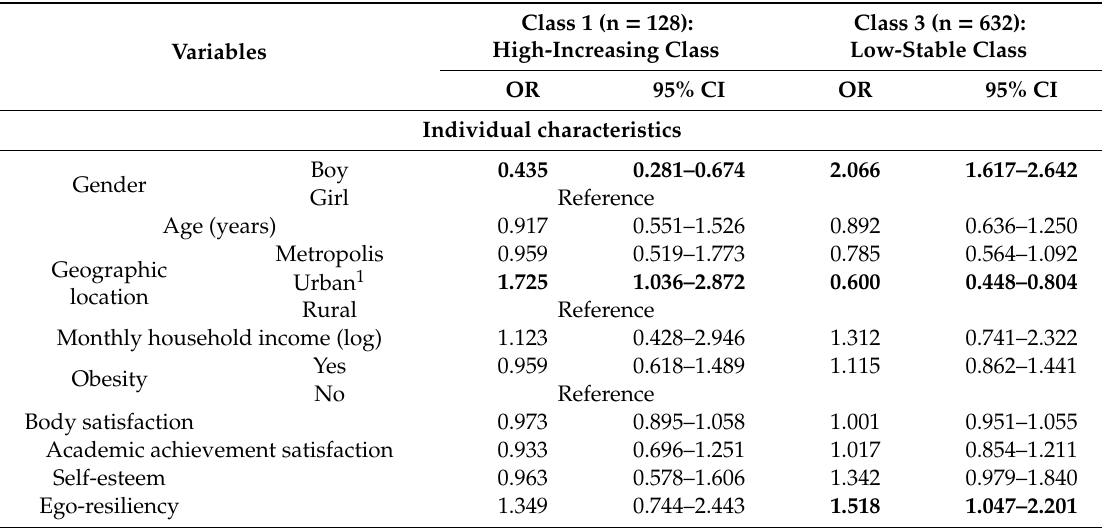
Table 5. Multinomial logistic regression